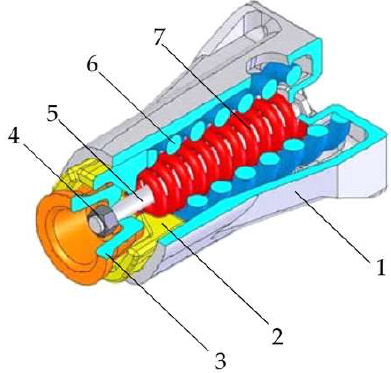
Figure 1. Sh-2-B-90 absorbing mechanism: 1, body; 2, friction wedge; 3, pressure cone; 4, nut; 5, bolt; 6, external spring; 7, internal